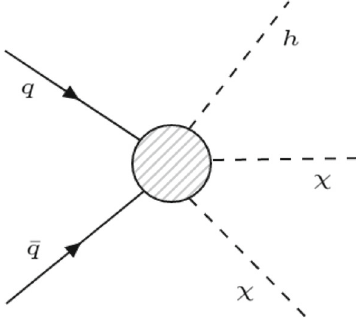
Fig. 4 Generic diagram for mono-Higgs + / E T signal with contribu- tions from dimension-6 and -8